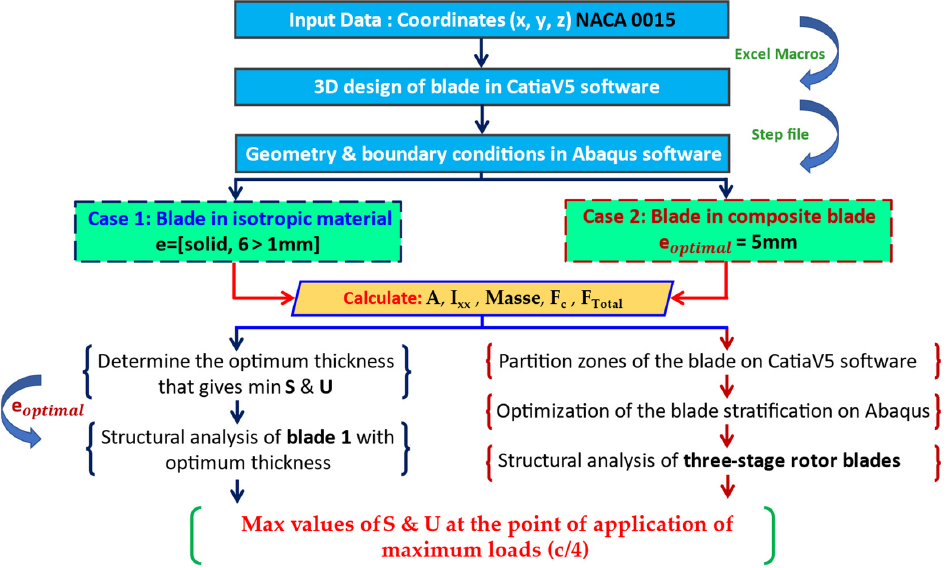
Figure 7. General approach to the structural analysis of composite blades of vertical axis wind turbines with three-stage rotors.